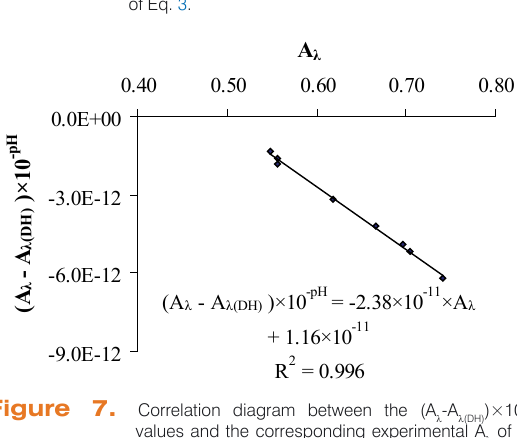
Figure 6. Correlation diagram between the (A values and the corresponding experimental A molecule in low pH range at λ =508 nm by application of Eq.